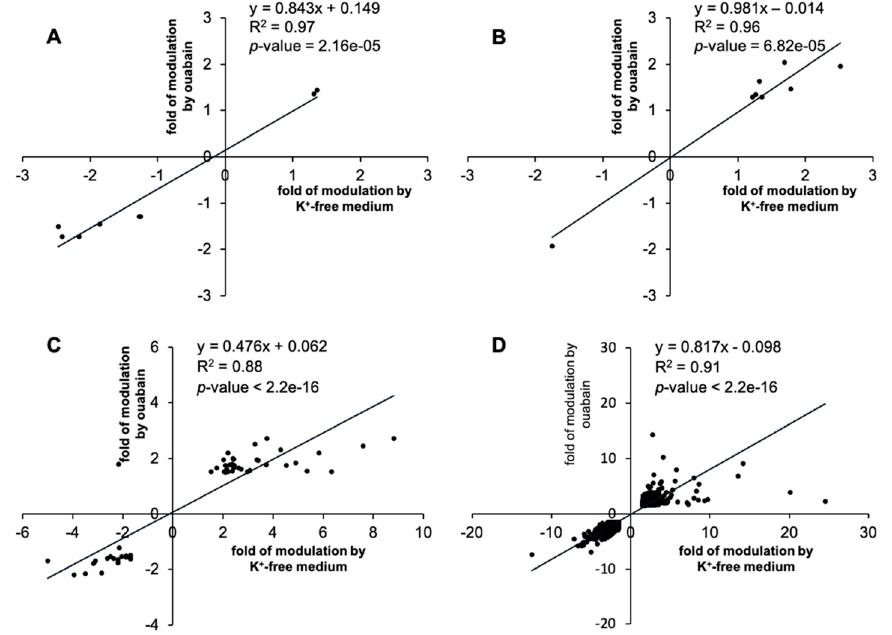
Figure 4. Correlation analysis of genes whose expression was changed by Na,K-ATPase inhibition in the presence of 3 μ M ouabain or K + -free medium in 0.5 ( A ), 1 ( B ), 2 ( C ), and 6 h ( D ) by more than 1.2-fold with p < 0.05. The total number of genes subjected to analysis is shown in Figure 2.